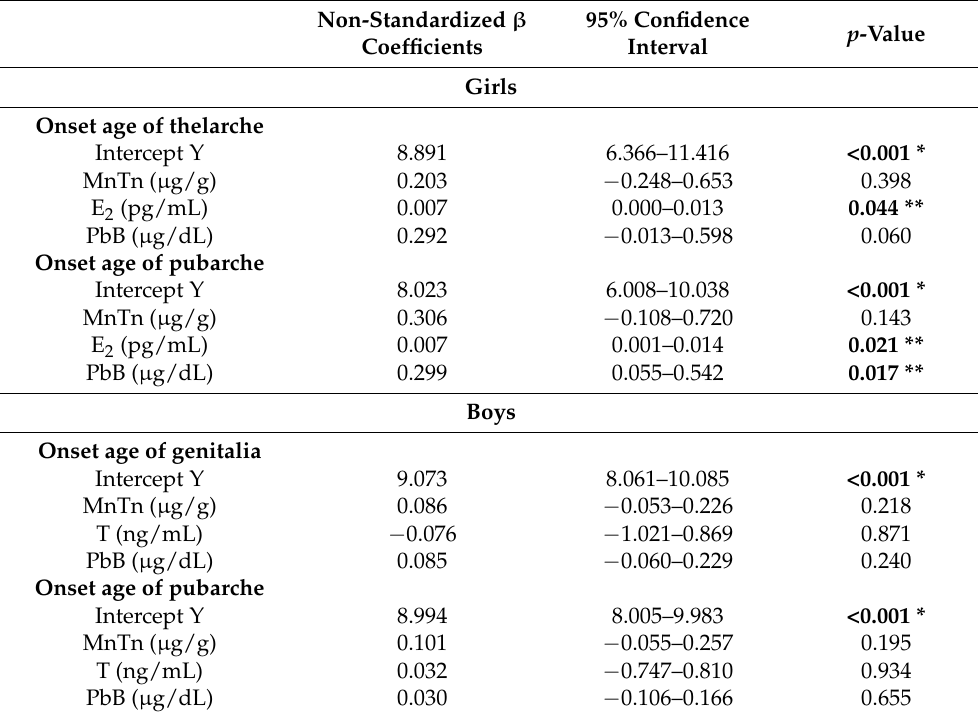
Table 5. Multivariate linear regression model for Mn biomarker as predictor of early age (years) of puberty onset on